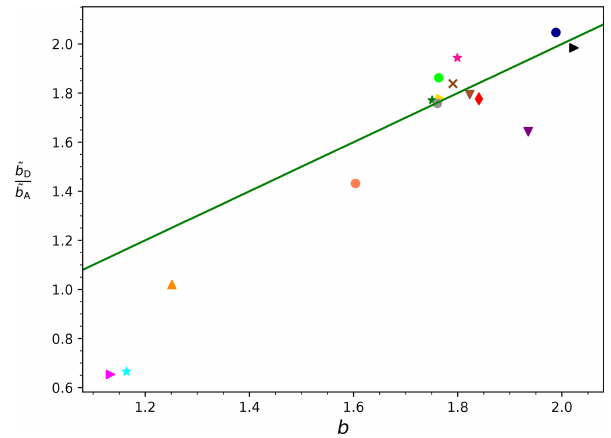
Figure 2. Ratio of the exponents ˜ b D and ˜ b A from the m vs. D max and m vs. A relationships, respectively, and the exponent b corre- sponding to the A vs. D max relationship are shown for all the shape groups. The solid green line corresponds to the general relationship ˜ b = b (derived from Eqs. 8, 9, and D between the slopes, ˜ b A